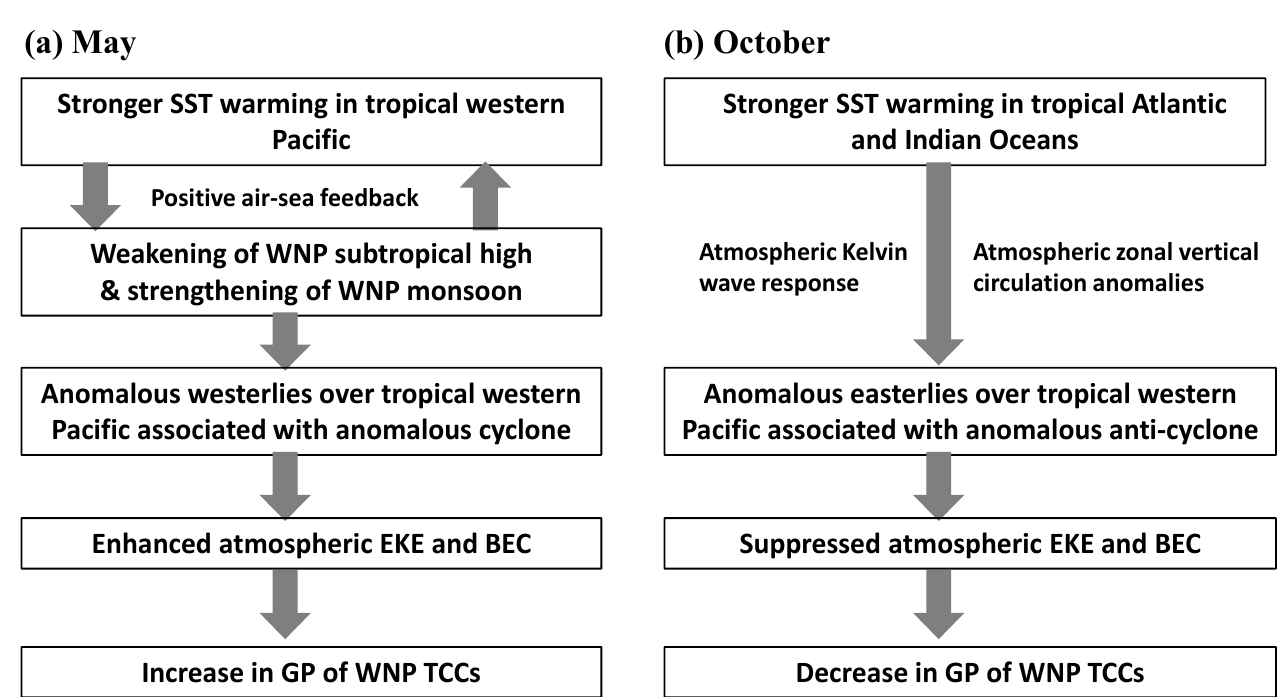
Figure 12. Schematic diagram showing the process for recent opposite changing tendencies in GP of WNP TCCs in ( a ) May and ( b ) October.